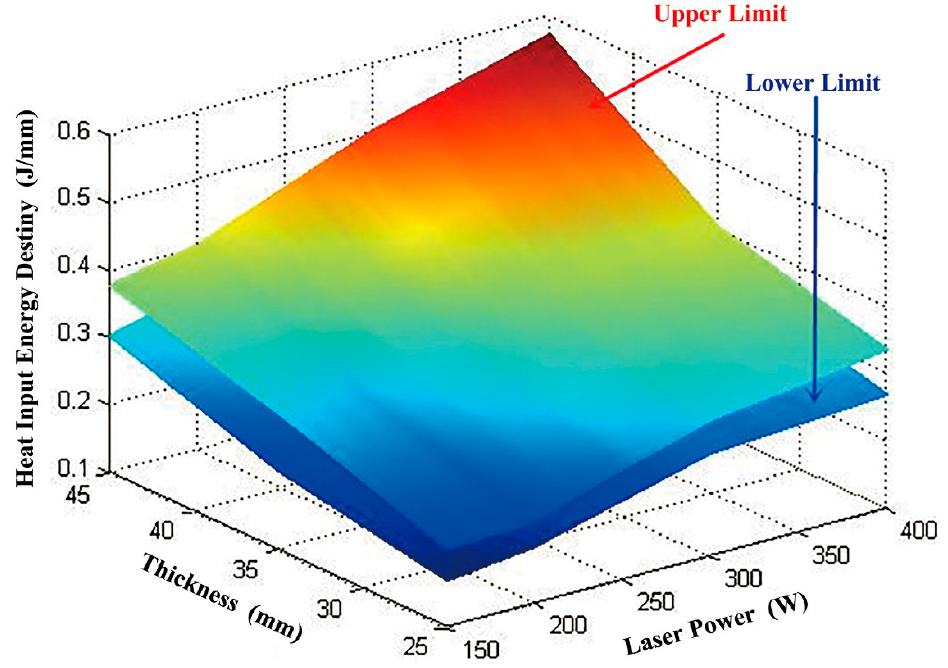
Figure 6. Energy input vs. parameter ranges under varying thicknesses.